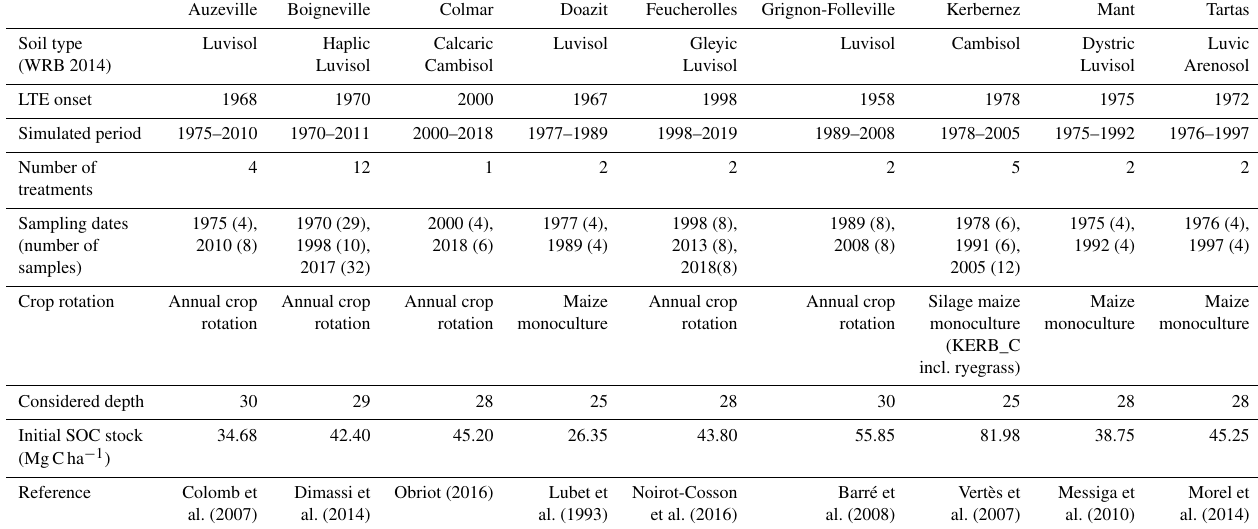
Table 1. Main information about the nine French agricultural long-term experiments used in this study. All sites had been croplands for at least 20 years before the onset of all experiments. Additional site information including climatic variability amongst sites and long-term history of land cover is provided in Supplement Table S1. WRB: World Reference